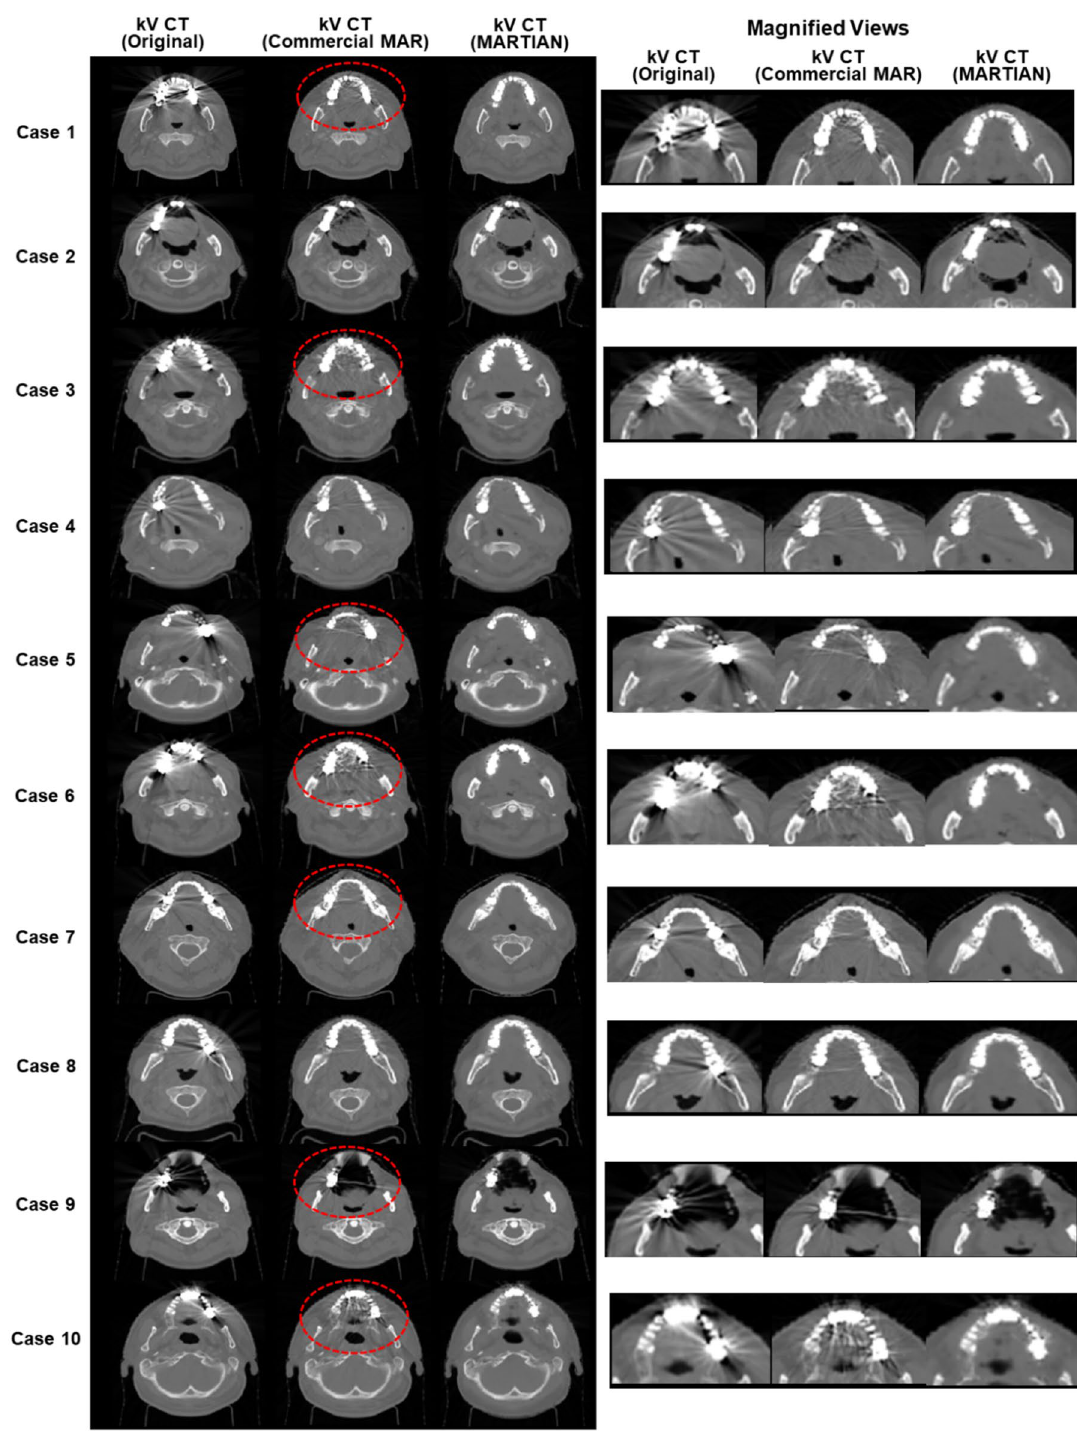
Figure 6. Resulting images from two-step sequential deep neural network for 10 test cases (third column), compared against metal contaminated true kV CT and kV CT images from commercial MAR (Canon SEMAR) (kV CT: [−1000 HU, 1500